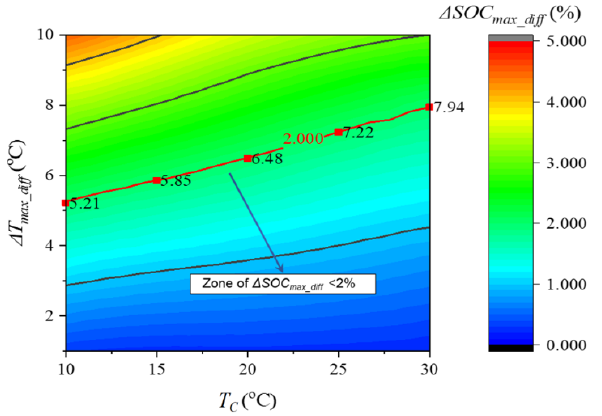
Figure 15. Relationship among T c , ∆ T max_diff and ∆ SOC max_diff under the inhomogeneous cooling case 13.